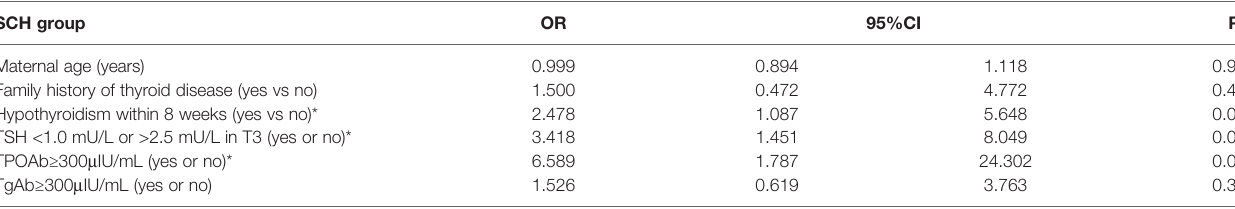
TABLE 4 | Logistic regression model for the risk factors of LT4 retreatment in all SCH women (n = 101). SCH group OR 95%CI Maternal age